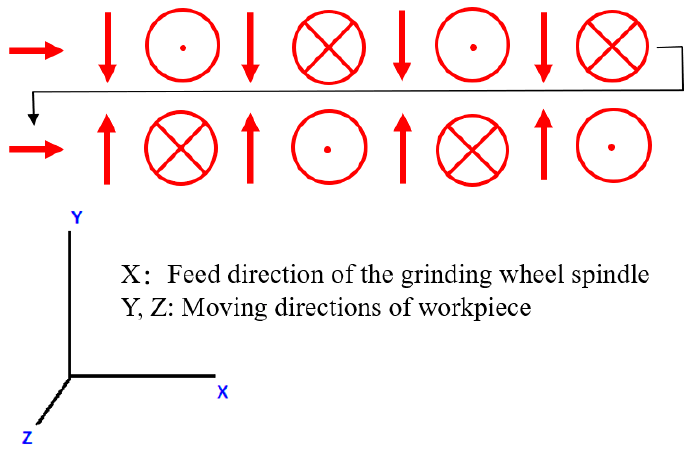
Figure 2. Schematic diagram of grinding path. Table 1. Grinding parameters of proposed measurement method.